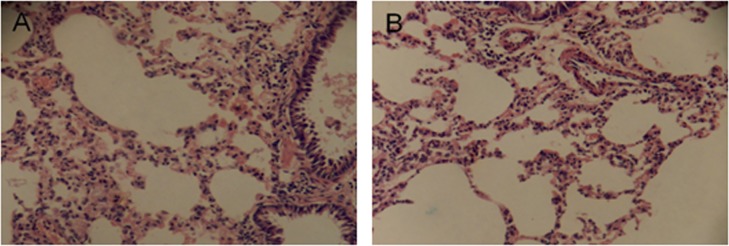
Representative hematoxylin and eosin staining (H&E, 100×) of lung sections.(A) from the control group, (B) from the experimental group. Dilatation and congestion of the capillary vessels around the alveoli, edema fluid in the alveoli, and lymphadenosis under bronchial mucosae were commonly observed in the lung sections from both groups. No significant differences were found between the experimental group and the control group.